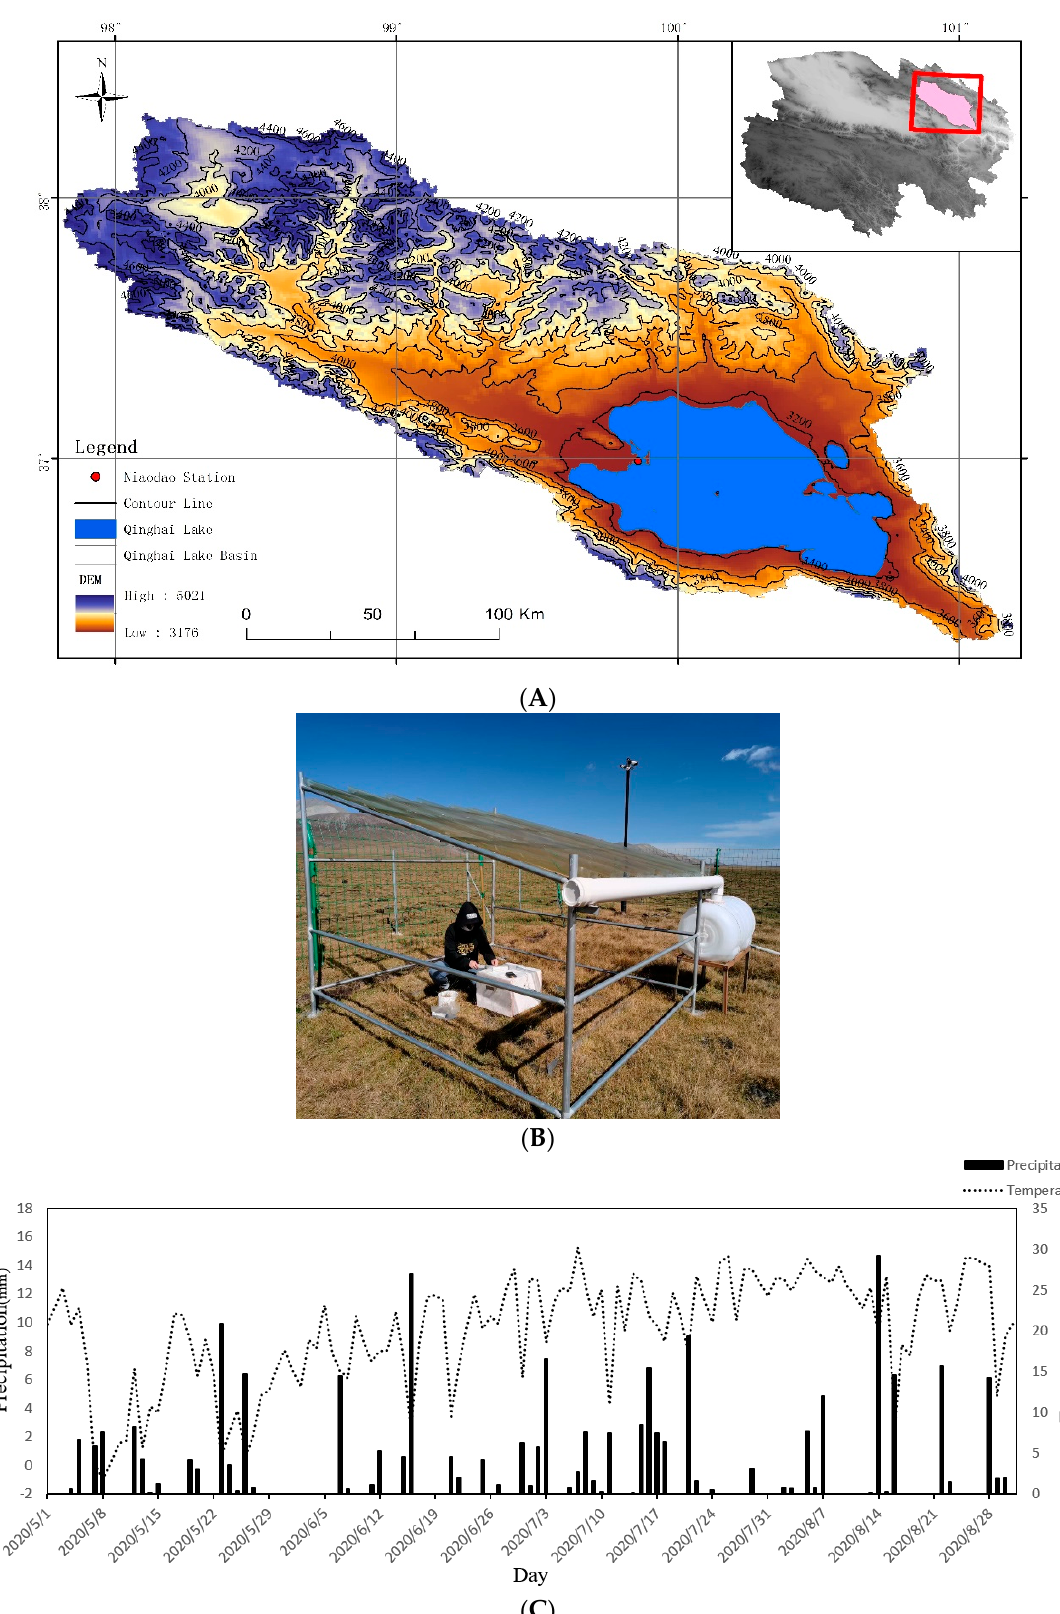
Figure 1. Overview map of the study area ( A ). Field precipitation simulation device ( B ). Precipitation and temperature from May to August in the study area ( C ).